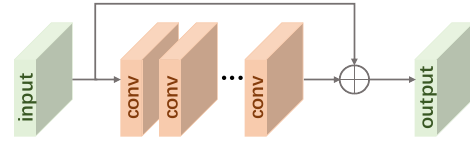
Figure 5. The structure of residual